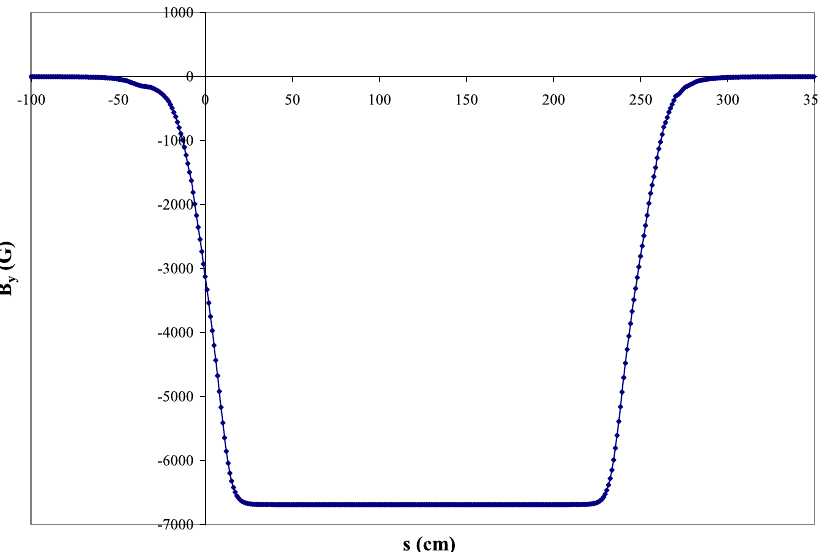
FIG. 7. (Color) Magnetic dipole field on reference trajectory for extracted beam.